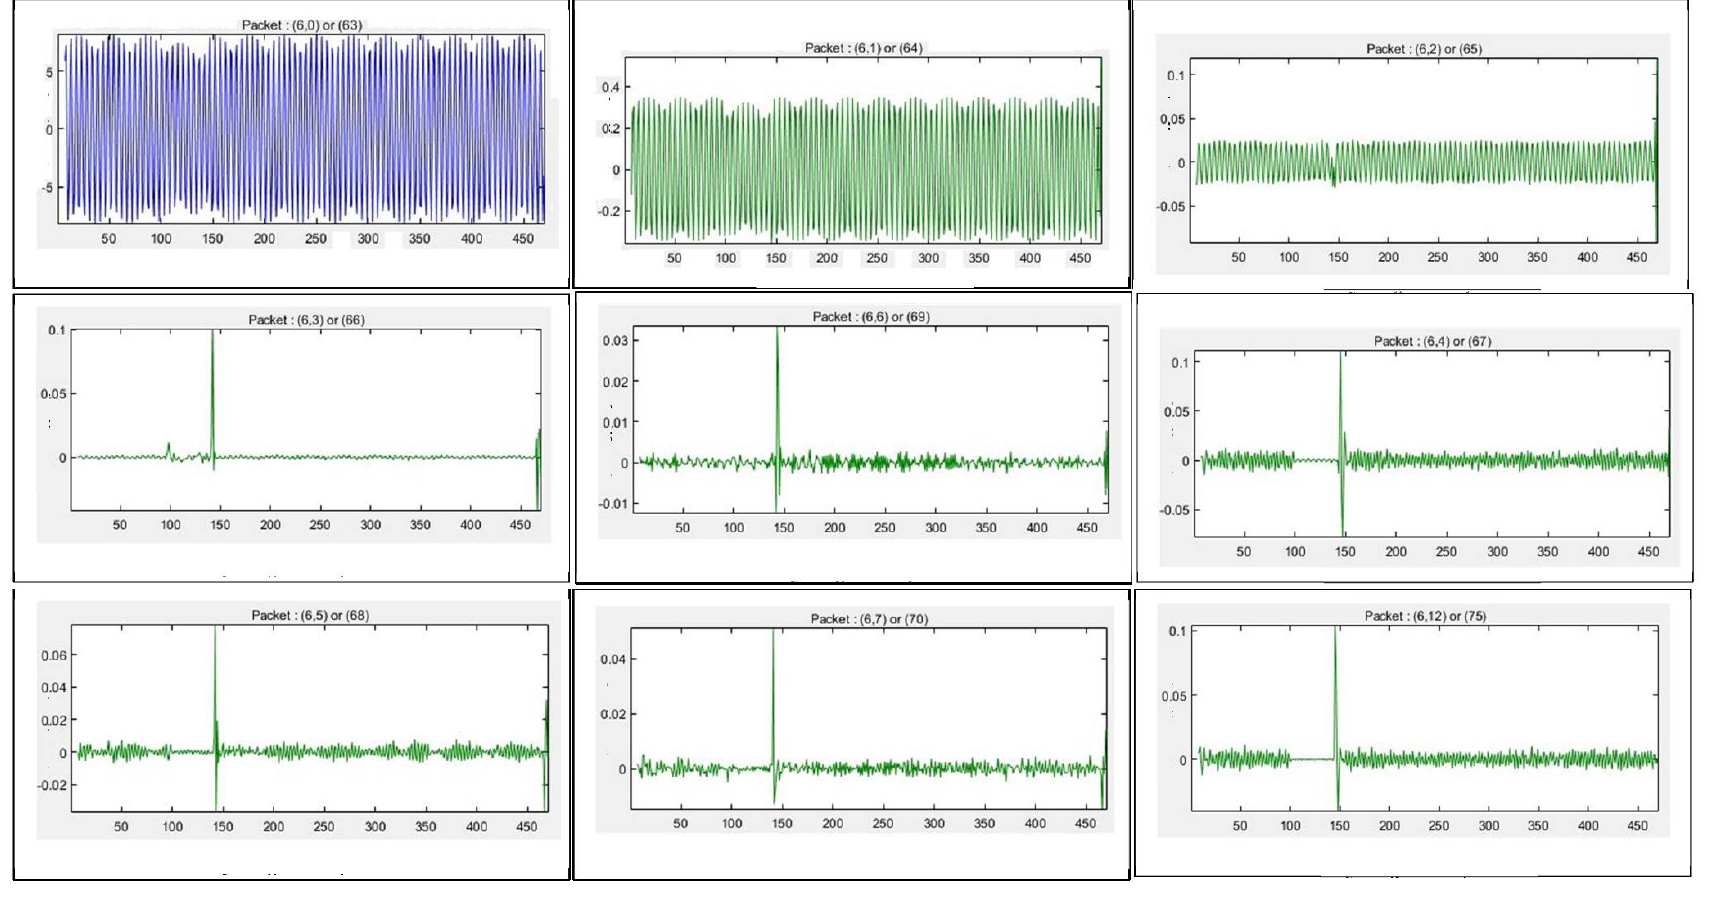
Figure 7 . Wavelet packet coefficients of PCC voltage when local loads match with local generation at level 6 with “db4” wavelet.